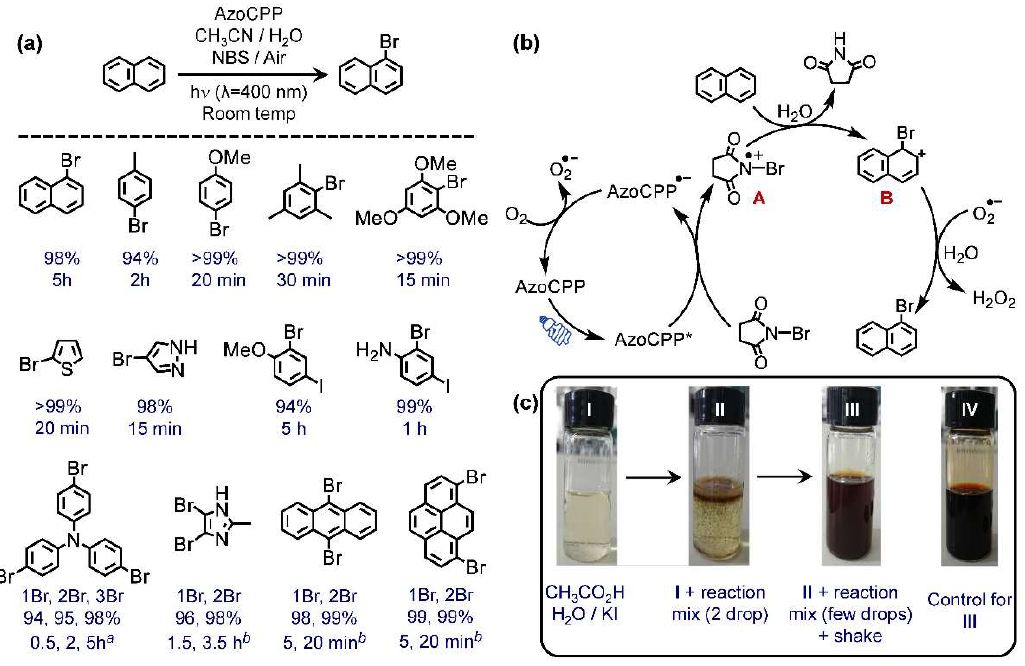
Figure 4. ( a ) Photocatalytic bromination of arenes with corresponding substrate scope and product yields (GC), a 3 times more NBS was used, b 2 times more NBS was used; ( b ) proposed mechanism for the reaction; and ( c ) qualitative proof for H 2 O 2 generation.